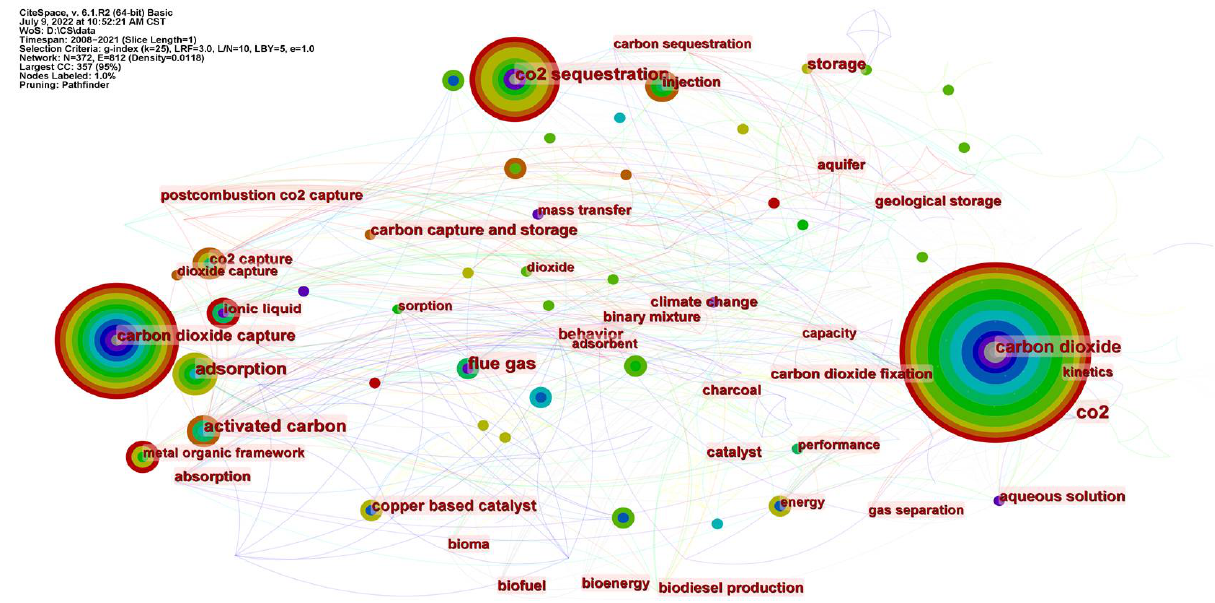
Figure 22. Keyword co-occurrence map.